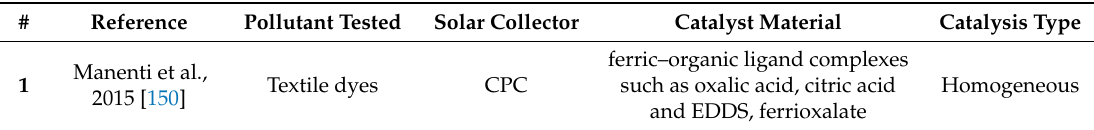
Table 9. Real wastewaters